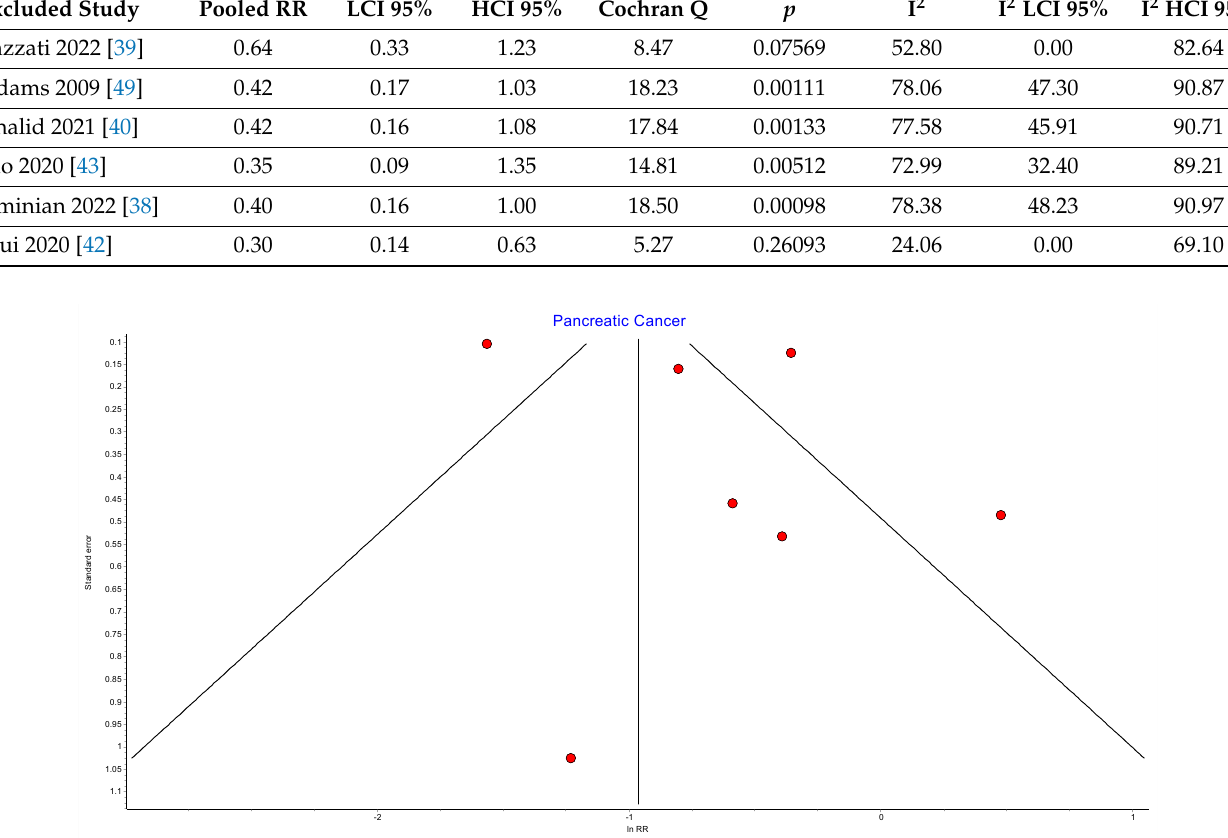
Table A15. Gallbladder cancer random e ff ects model sensitivity analysis.